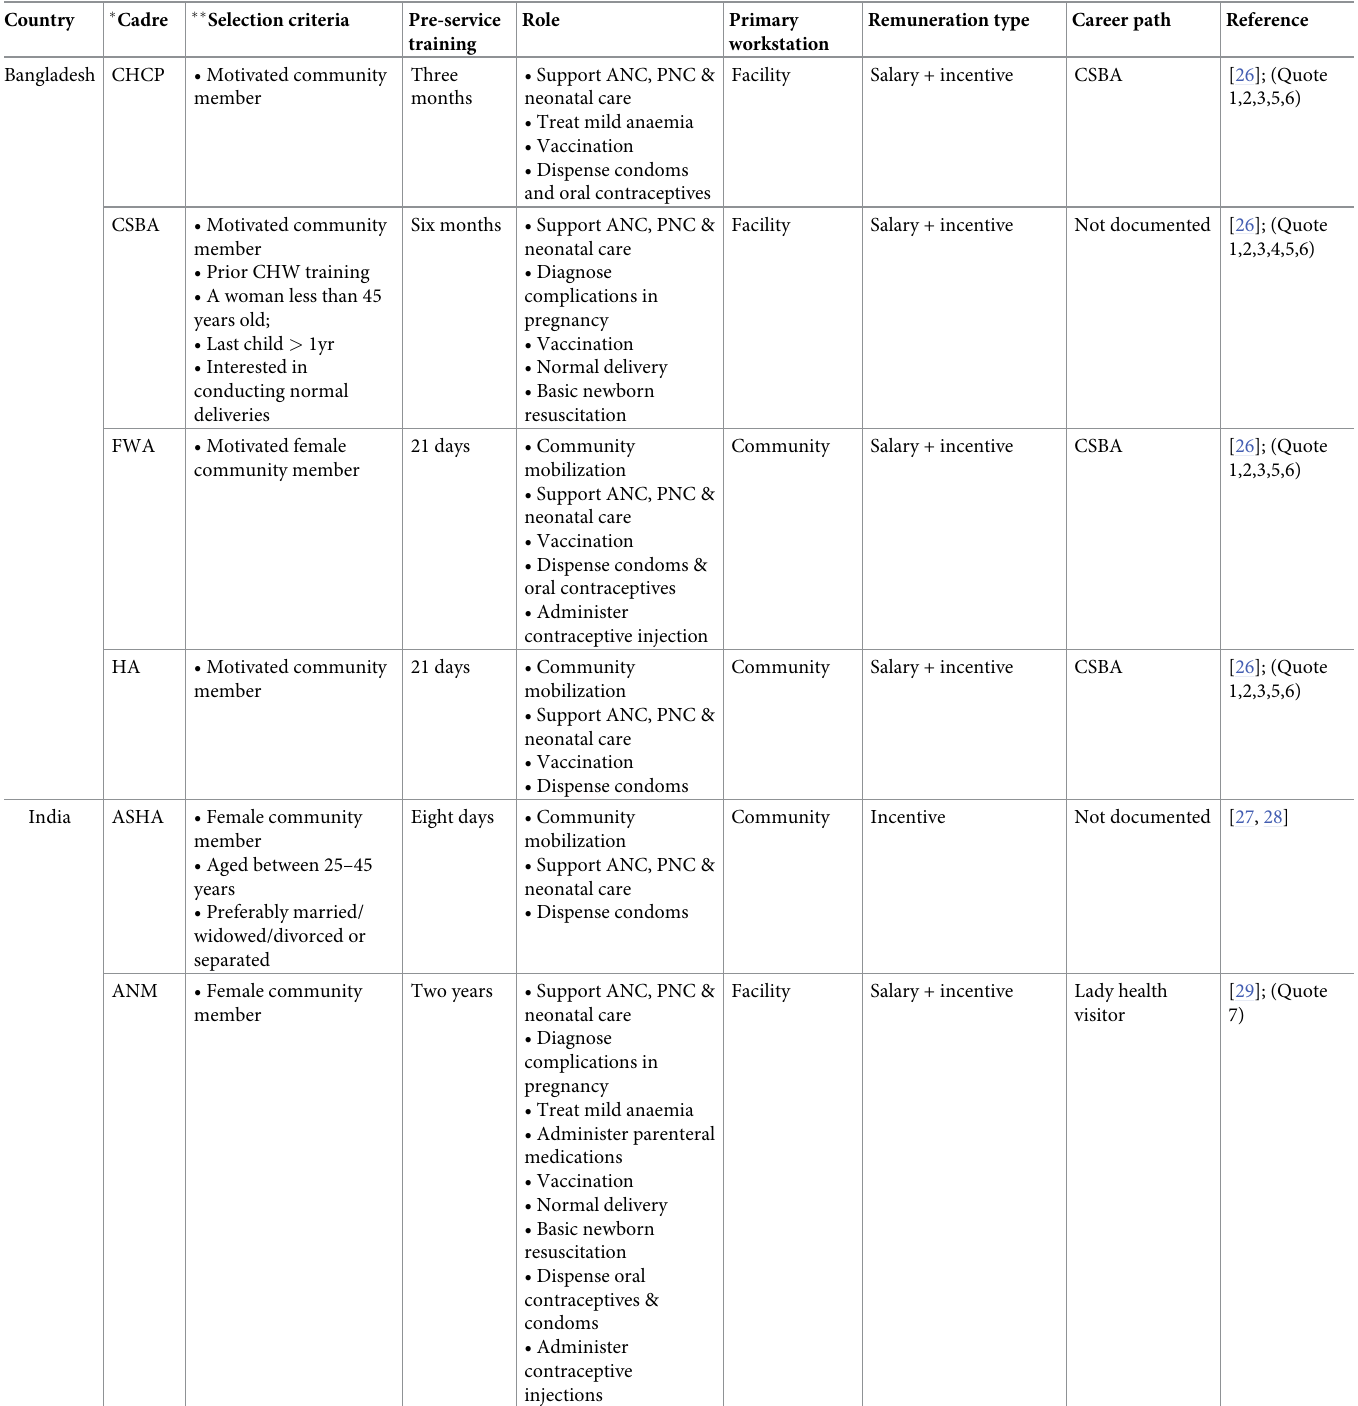
Table 2. Characteristics of the CHWs in study countries (adapted from Olaniran et al. 2021) [18].